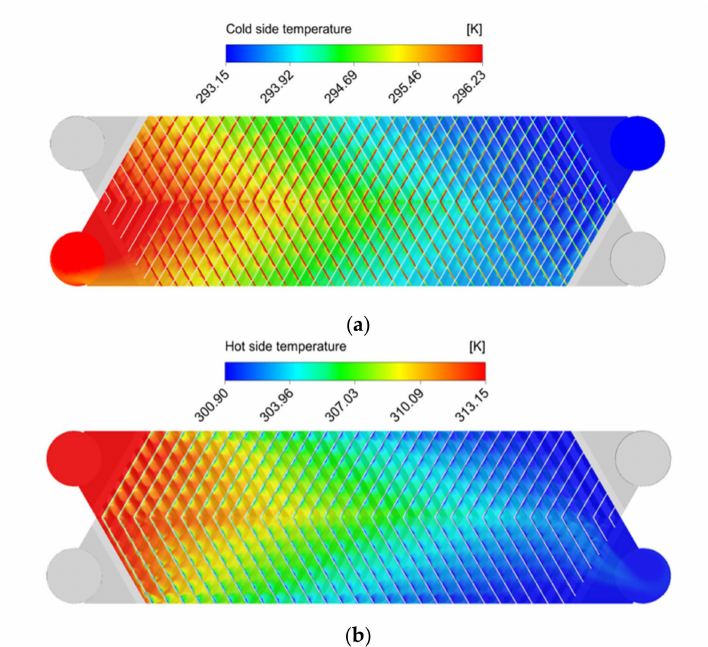
Figure 5. Temperature distribution at channels: ( a ) cold side, ( b ) hot